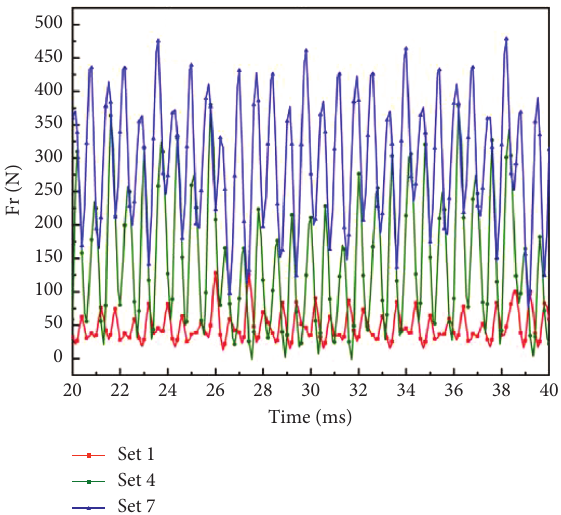
Figure 11: REF versus time for optimal φ , β